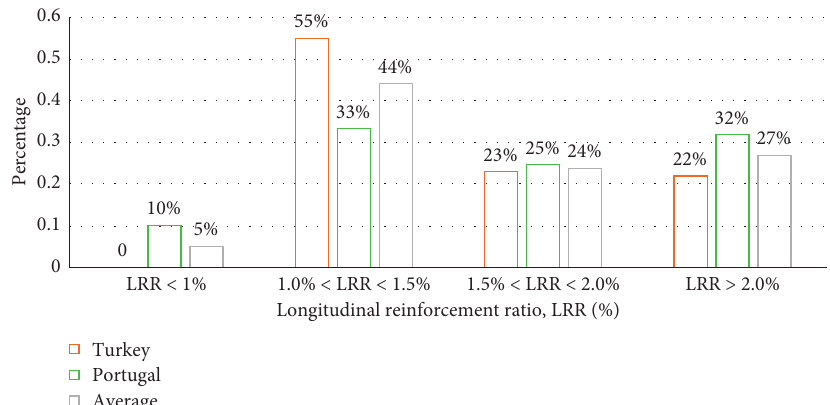
Figure 32: Comparison of longitudinal reinforcement ratio of precast RC buildings in Portugal and Turkey.